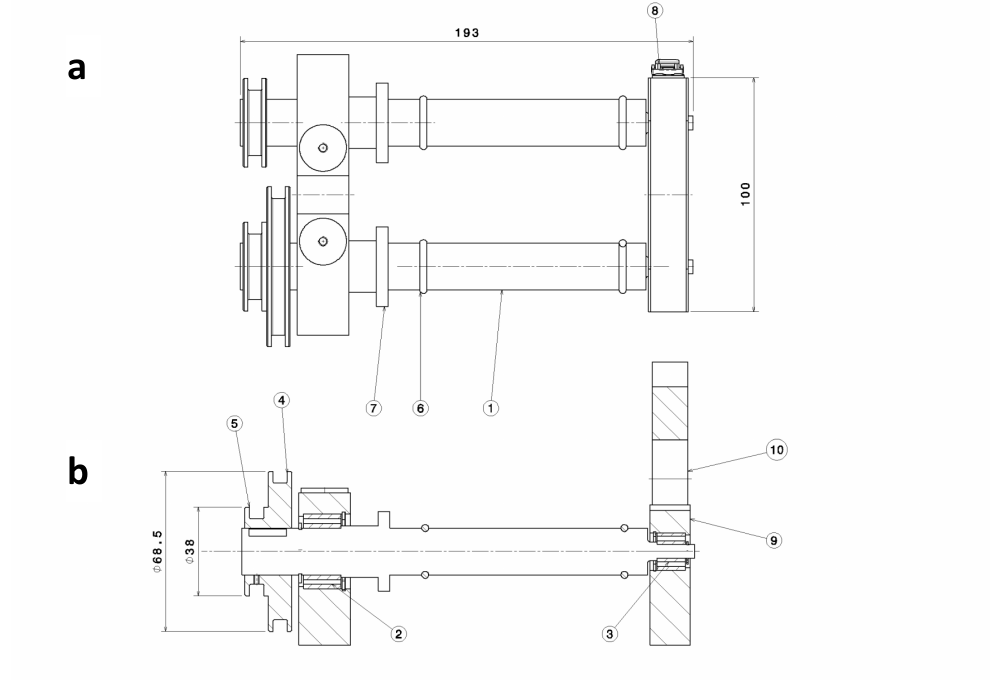
Figure 4. Top view of the mixer ( a ) and a transversal section through the front shaft ( b ). The mixer is composed of two shafts (1), ball bearings (2, 3), and wheels (4, 5) for rotation. An O-ring (6) prevents the seeding cylinder from slipping. A guardrail (7) and a latch (8 + 10) secure the seeding cylinder on the mixer. The shafts are assembled on a base